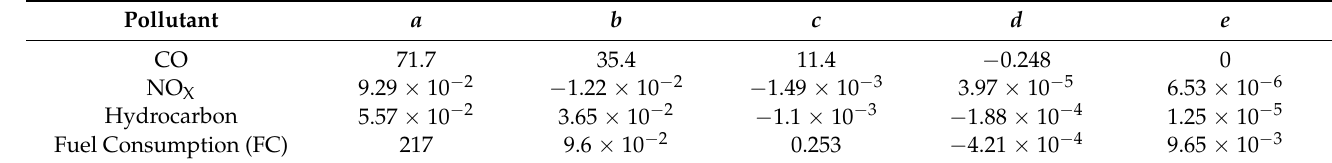
Table 2. Parameters of emission factors for different pollutants in COPERT III